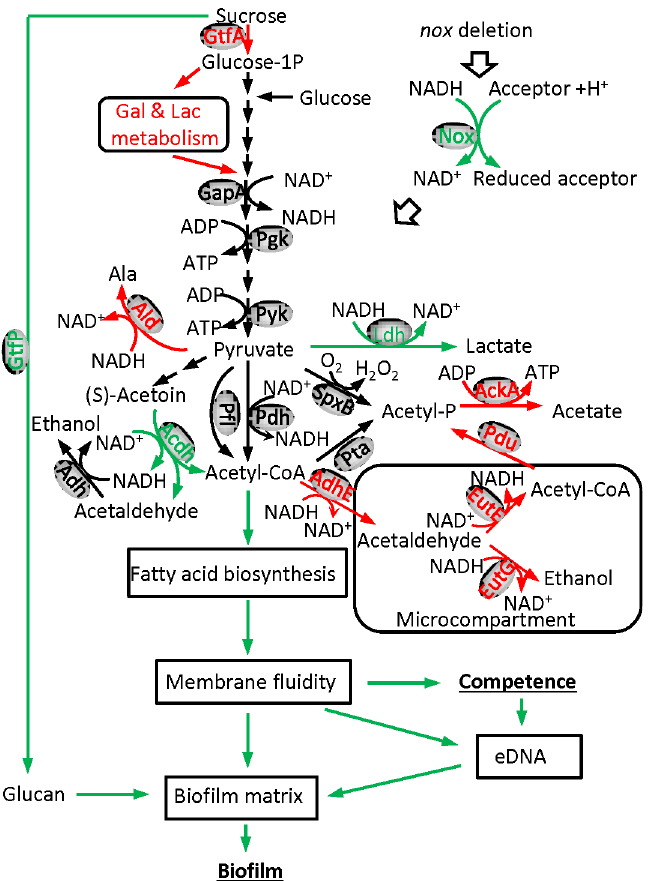
Fig 8. Deduced mechanisms of the nox gene in relation to biofilm formation in S . sanguinis . Deletion of nox leads to cessation of the nox – mediated oxidation of NADH to NAD + . This causes decreased expression (green) of ldh and two genes encoding components of acetoin dehydrogenase, acoA and acoB , and increased expression (red) of adhE , ackA , ald and ethanolamine utilization genes including eutG , eutE and pdu . These gene expression changes affect the associated pathways to partially compensate for the imbalance of NAD + /NADH caused by nox deletion. Meanwhile, gtfA (red) expression increases and gtfP (green) expression decreases, which may cause more sucrose influx into energy metabolism rather than exopolysaccharide biosynthesis (e.g. glucan). Increased consumption of acetyl-CoA by AdhE may influence fatty acid biosynthesis to alter the membrane fatty acid components and to subsequently decrease the membrane fluidity and may suppress the release of eDNA. The inhibition of DNA release and glucan biosynthesis impairs biofilm matrix and results in defective biofilm formation. Green arrow, reduced reaction or function in the nox mutant; black arrow, normal reaction or function; red arrow, increased reaction or function; hollow arrow, function lost as a result of the nox